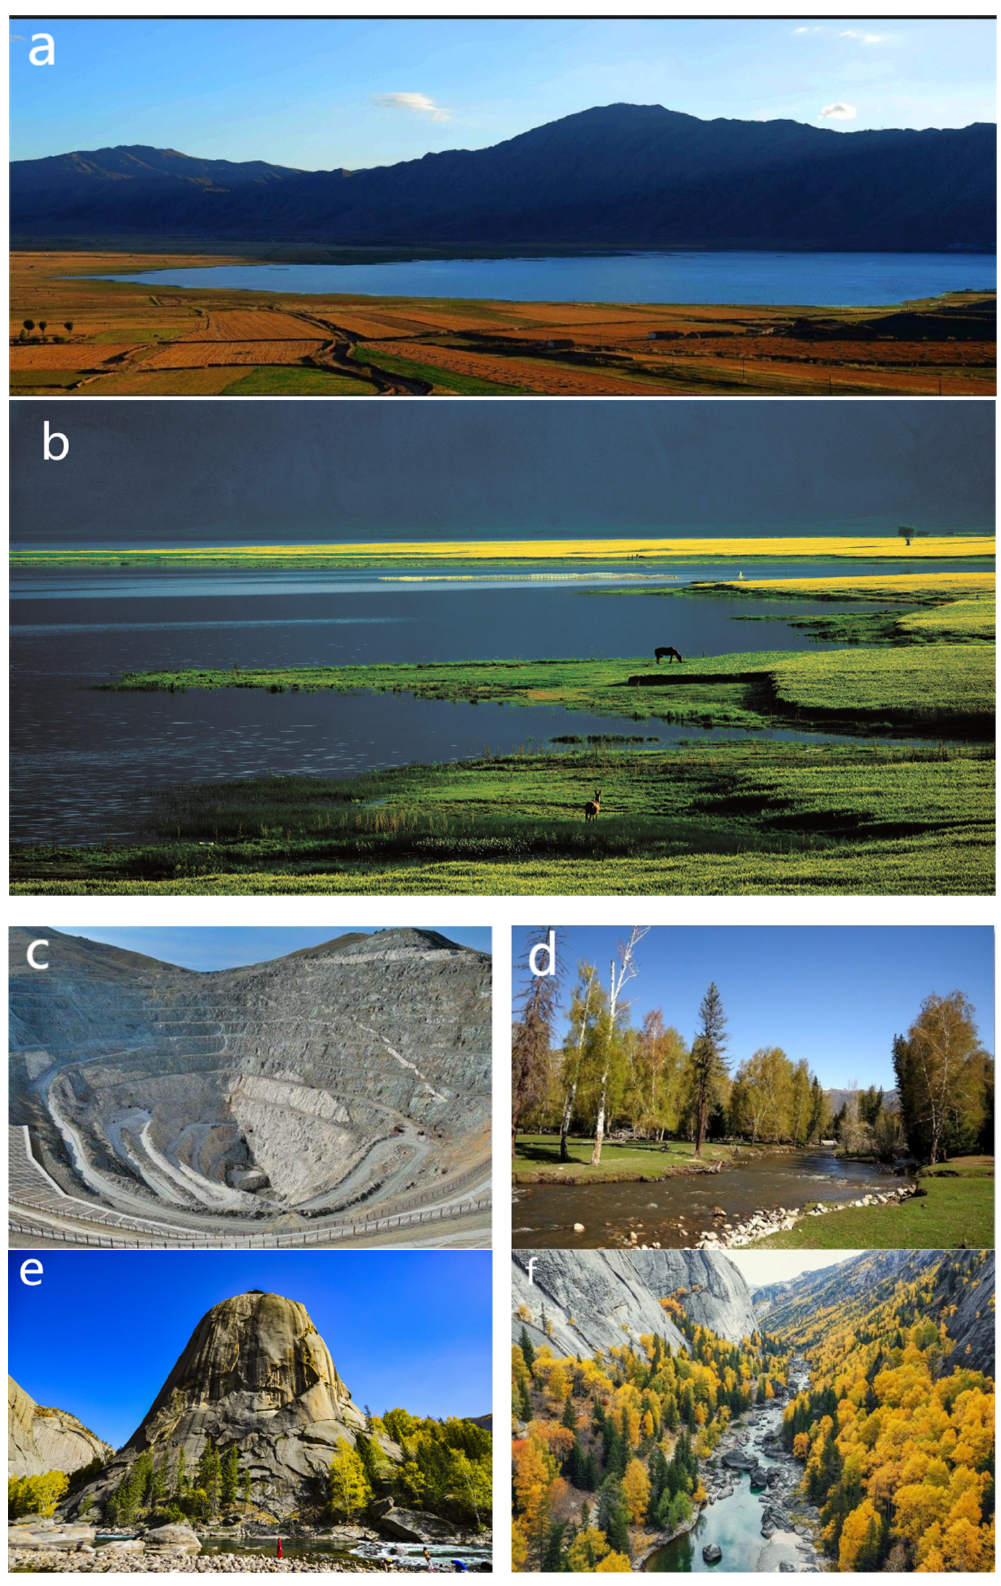
Figure 2. The representative scenic spots of the Koktokay Global Geopark. ( a ) Eremu Lake; ( b ) Cocosuri; ( c ) the No. 3 Mine Pit; ( d ) Betula forest; ( e , f ) Shenzhong Canyon.